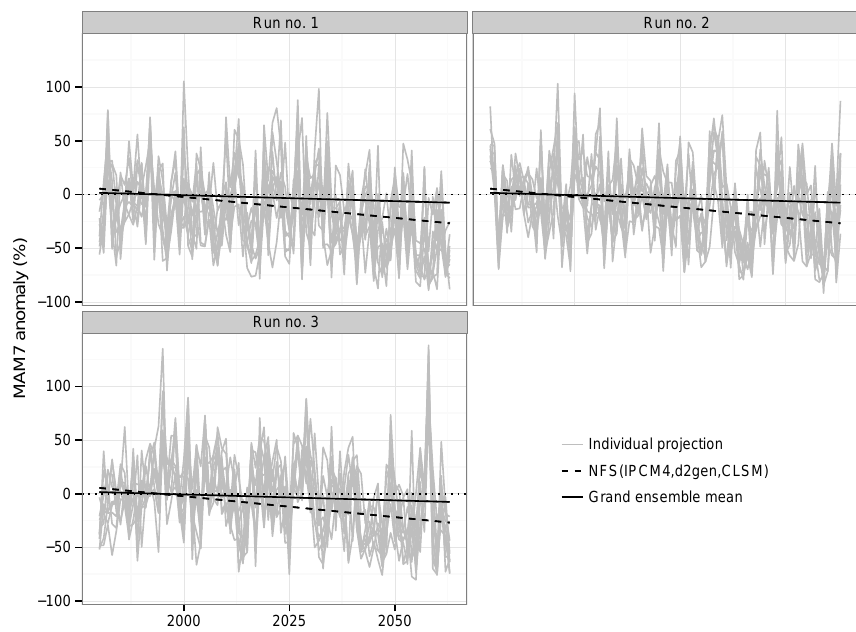
Figure 3. Winter low-flow NFS( g = IPCM4, s = d2gen, h = CLSM) for the Durance@Serre-Ponçon, fitted to all 30 projections available as combinations of the IPCM4 GCM (3 runs), the d2gen SDM (10 realizations), and the CLSM HM. Each panel shows 10 d2gen realizations from a given IPCM4 run as well as the common NFS and the grand ensemble